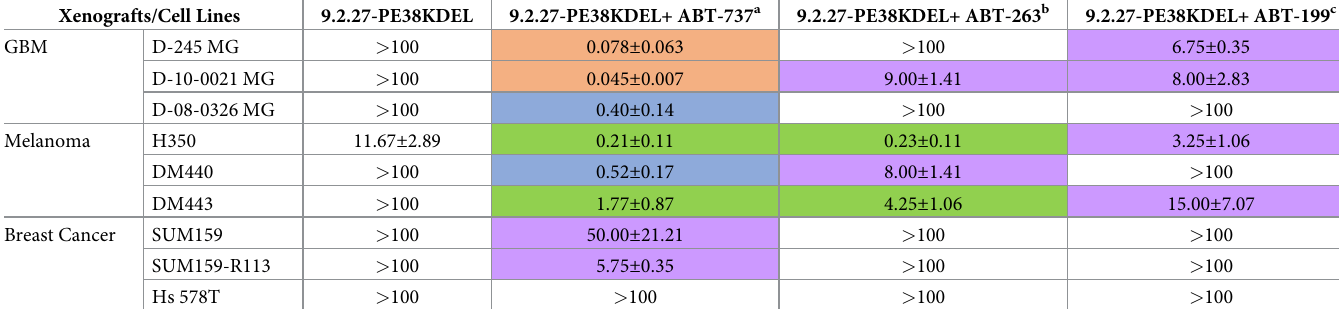
Table 2. In vitro cytotoxicity (IC 50 ng/ml) of ABT-737, ABT-263, or ABT-199 in combination with 9.2.27-PE38KDEL immunotoxin. Xenografts/Cell